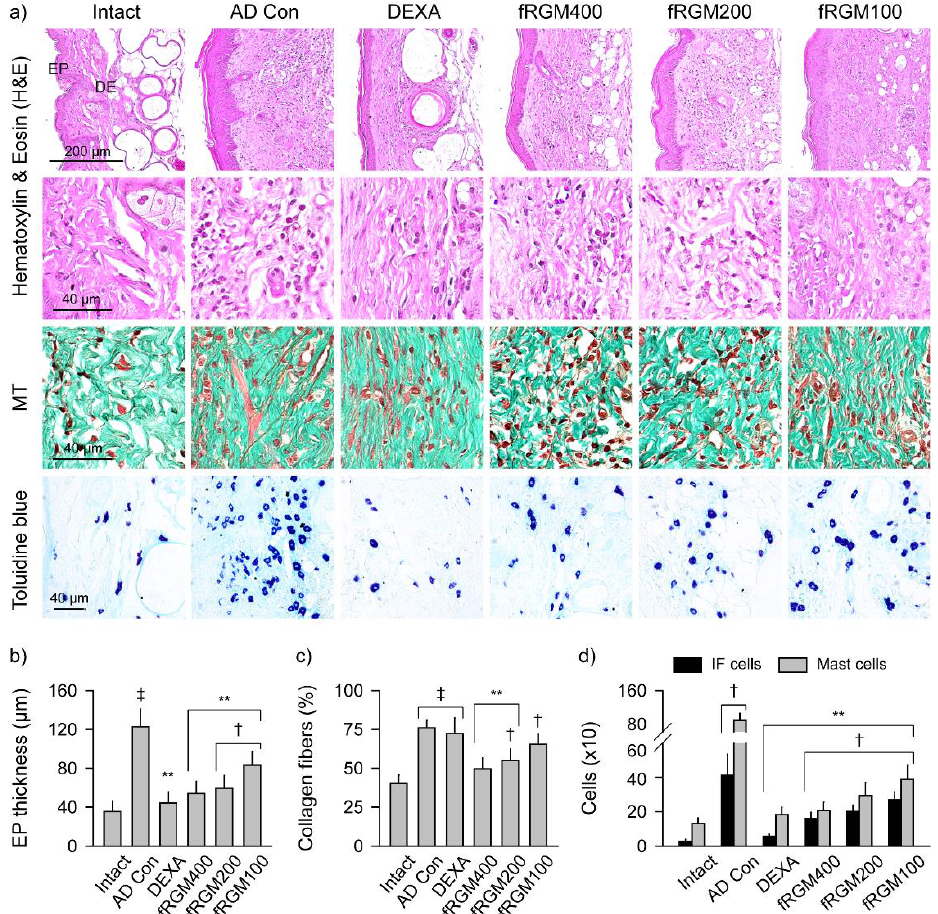
Figure 4. Histopathological changes in AD-like skin lesions. ( a ) Representative images in stains of H&E, Masson’s trichrome (MT) for collagen deposition, and toluidine blue for mast cells. In the H&E stains, the upper shows the epidermis (EP) and dermis (DE), and the lower is the high-magnified DE. ( b ) EP thickness (μm). ( c ) Collagen deposition (%/mm 2 ). ( d ) Number of inflammatory (IF) cells and mast cells in the DE (×10 cells/mm 2 ). Values are represented as means ± SDs. ‡: p < 0.01 and †: p < 0.05 vs. the Intact group; **: p < 0.01 vs. AD Con.